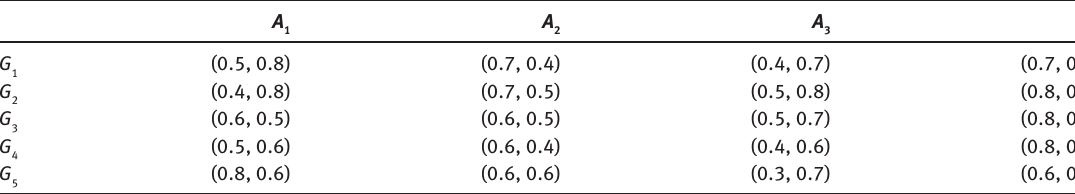
Table 5: Normalized Decision Matrix R 1